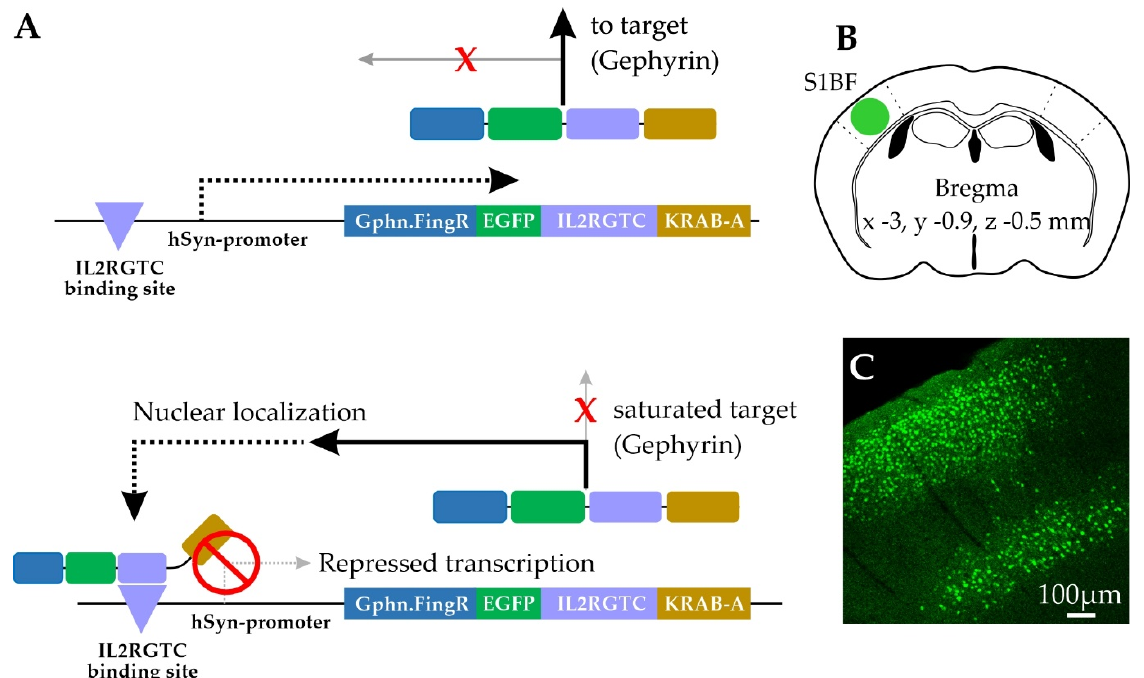
Figure 1. Zinc finger mediated transcriptional regulation of Gephyrin.FingR. ( A ) Adapted from Gross et al., 2013 [33]. The Gephyrin.FingR (Gphn.FingR) itself is fused to EGFP, the zinc finger (IL2RGTC), and the transcriptional repressor (KRAB-A). The zinc finger binding site was inserted upstream of the human synapsin promoter (hSyn). ( Top ) In the unsaturated state, Gephyrin.FingR is transcribed in the nucleus (dotted arrow), then the translated Gephyrin.FingR fusion protein binds to endogenous gephyrin in the cytoplasm (solid arrow). ( Bottom ) When all endogenous gephyrin is labeled with Gephyrin.FingR, the excess Gephyrin.FingR migrates back to nucleus due to a nuclear localization sequence that is part of the zinc finger domain. Back in the nucleus (dotted arrow), the fusion protein binds to the promoter via the zinc finger IL2RGTC and the transcriptional repressor KRAB-A prevents further transcription. Thus, the expression of Gephyrin.FingR is matched to the level of endogenous unsaturated gephyrin; ( B ) virus injection site coordinates for targeting primary somatosensory cortex barrel fields (S1BF); ( C ) low magnification image of transduced S1BF injection site showing L2/3 and L5 neurons with EGFP labeled nuclei.